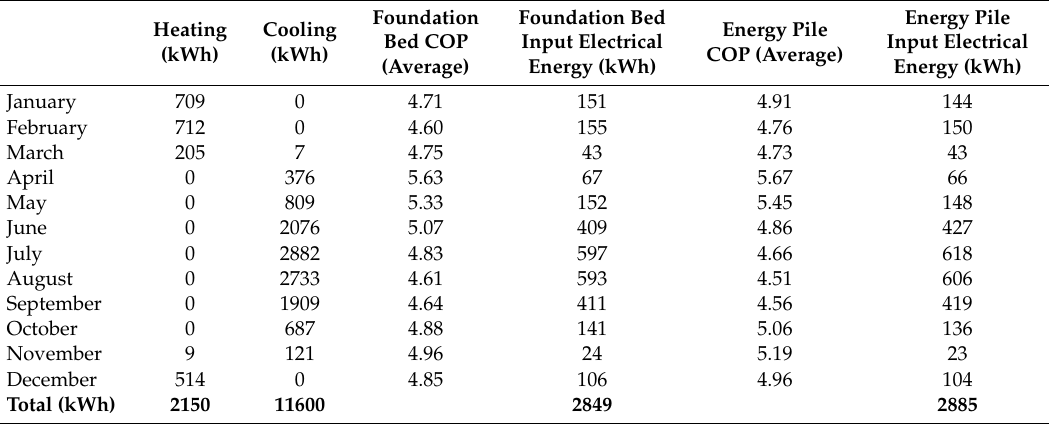
Figure 12. Estimated COP for the foundation bed and the energy pile systems. Table 7. Monthly and yearly average COP and input electrical energy for the two GSHP systems.